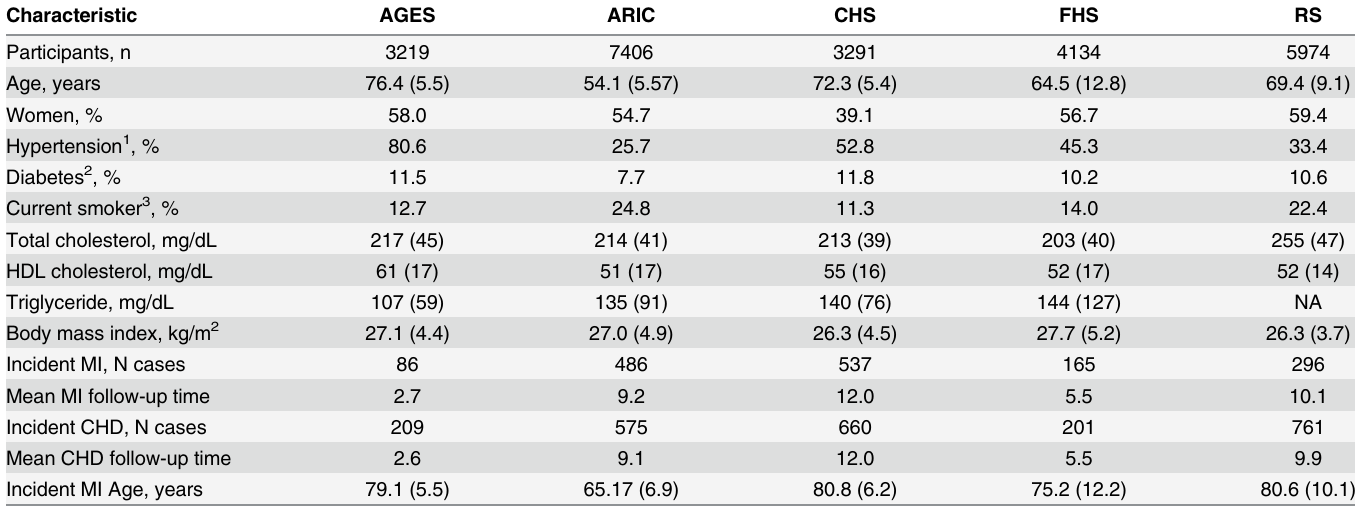
Table 1. Baseline characteristics of participants included in incident MI/CHD analysis stratified by cohort. Characteristic